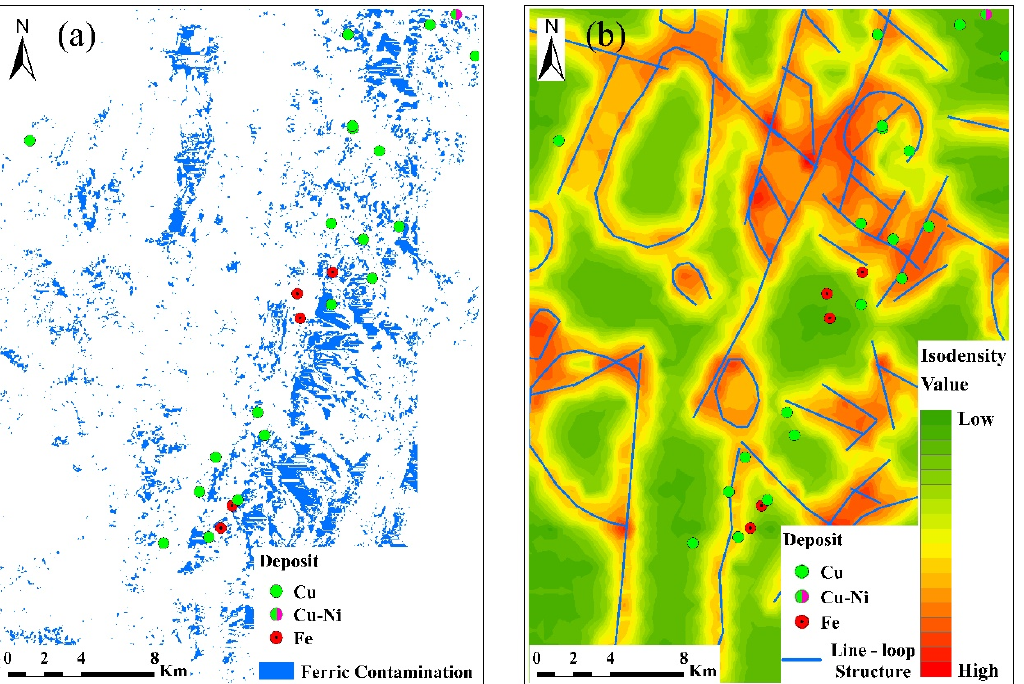
Figure 8. ( a ) Distribution map of iron-stained alteration information; ( b ) iso-density map of line– loop structure. loop